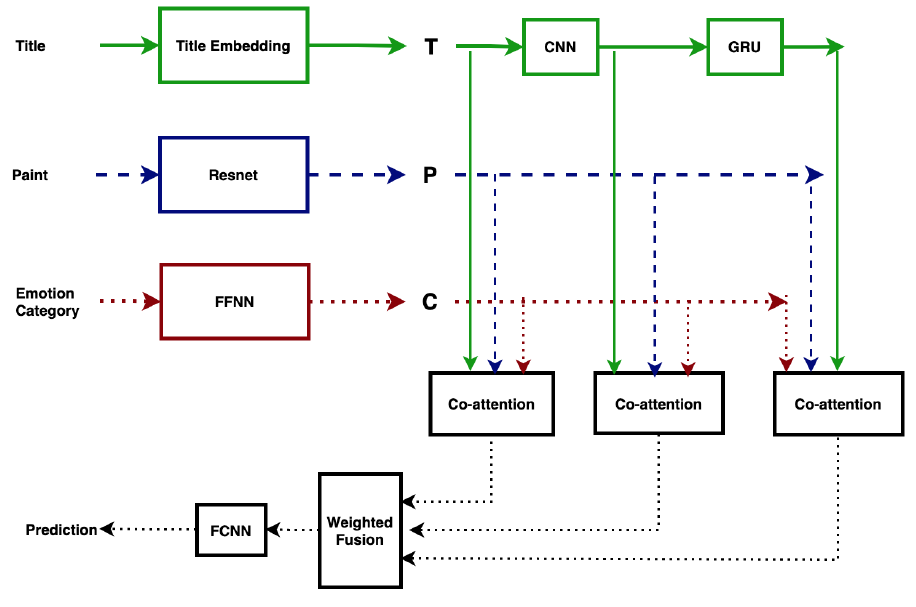
Figure 1. The proposed attention-based